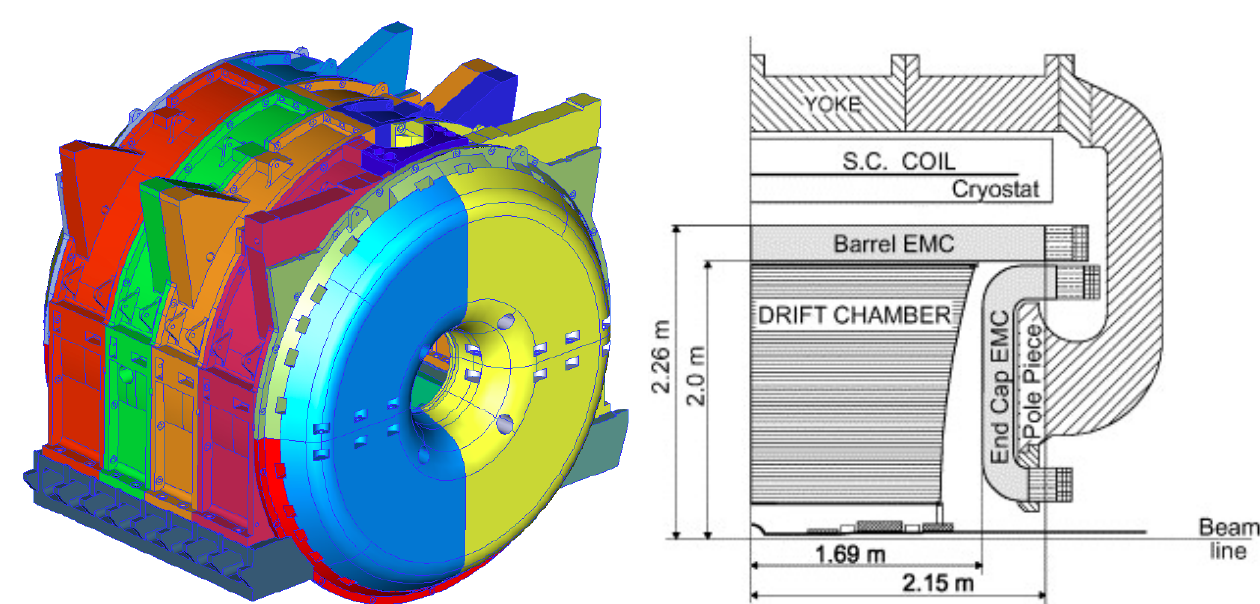
Figure 116. The KLOE detector: ( left ) 3D engineering CAD model of the magnet and ( right ) vertical cross section (taken from [127]).